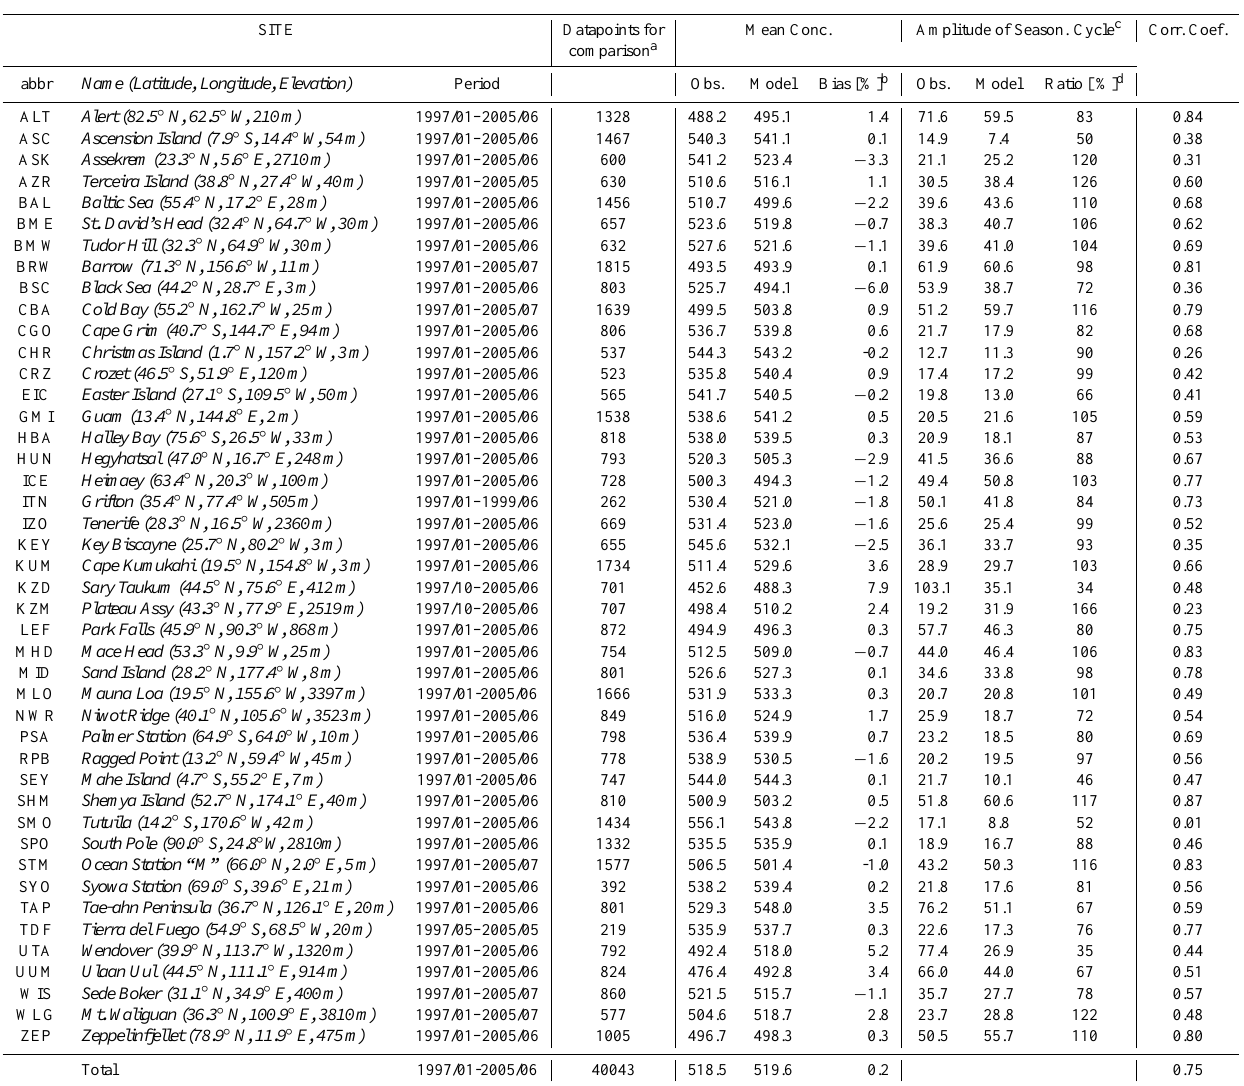
Table 1. Averaged mixing ratios, the amplitude of the seasonal cycles, and Pearson’s moment correlations between observed and simulated values for all sites considered in this